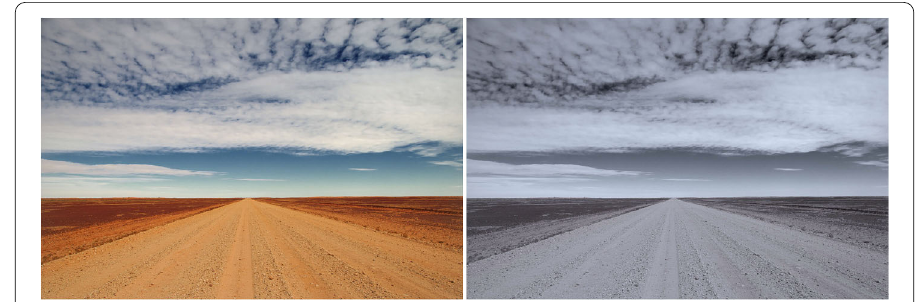
Figure 1 Comparison of HSV values . Right photograph has higher Hue (bluer), lower Saturation (grayer), and lower Brightness (darker) than left photograph. Instagram photos posted by depressed individuals had HSV values shifted towards those in the right photograph, compared with photos posted by healthy